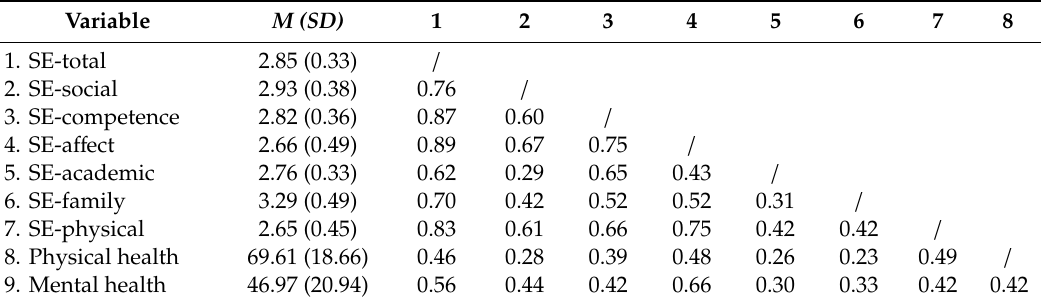
Table 1. Descriptive statistics and correlation coe ffi cients (whole